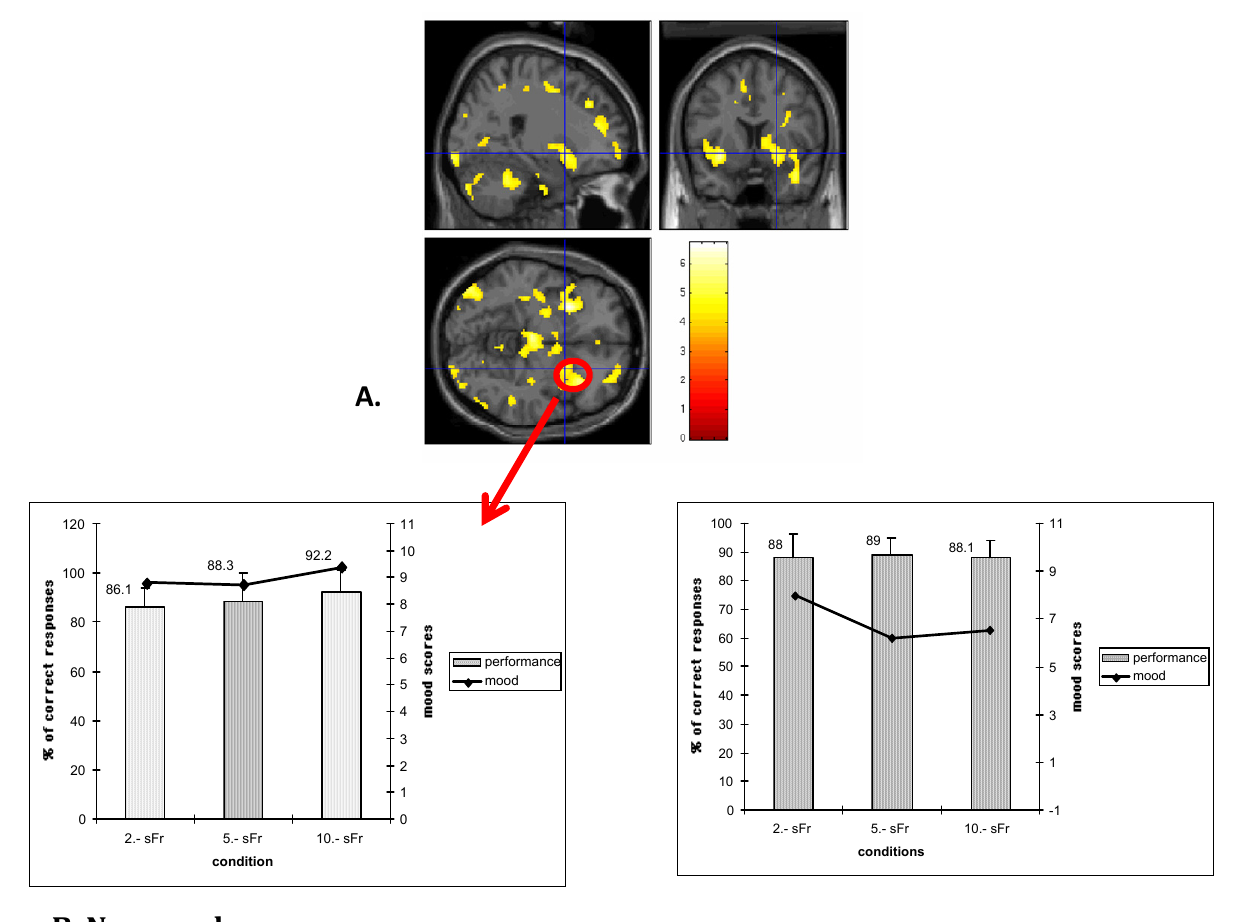
Figure 2. ( A ) Increased activation in the right striatum (putamen) in non-smokers in response to monetary rewards; in smokers, no striatal activation was found in response to monetary reward [47]. ( B ) The striatal activation was correlated with higher mood ratings evidenced in non-smokers in relation to increasing monetary rewards (CHF 2, CHF 5, CHF 10). ( C ) In smokers no mood increase was observed in association with increases of monetary rewards